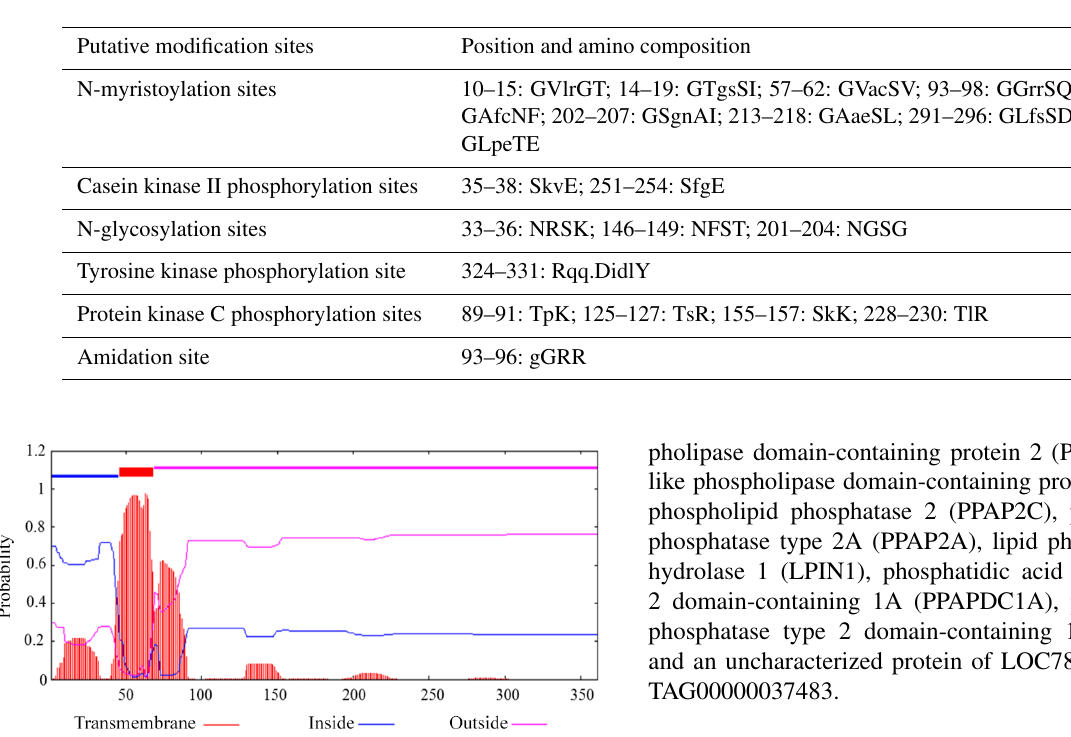
Table 3. Putative functional sites in buffalo DGAT2.